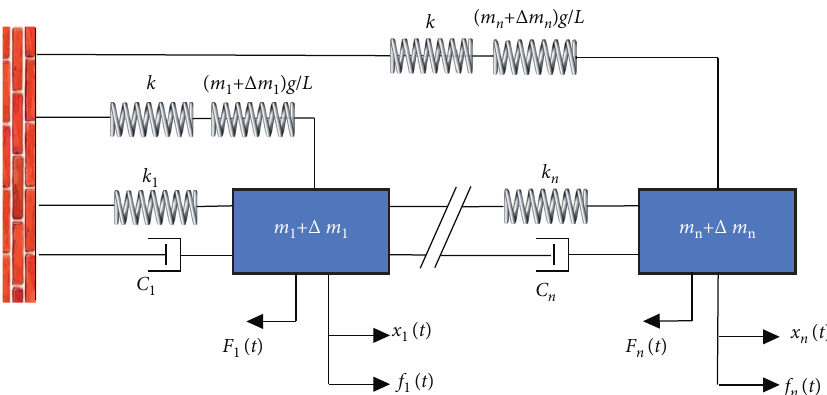
Figure 3: The theoretical model of the horizontal vibration of deployable solar arrays with multiple